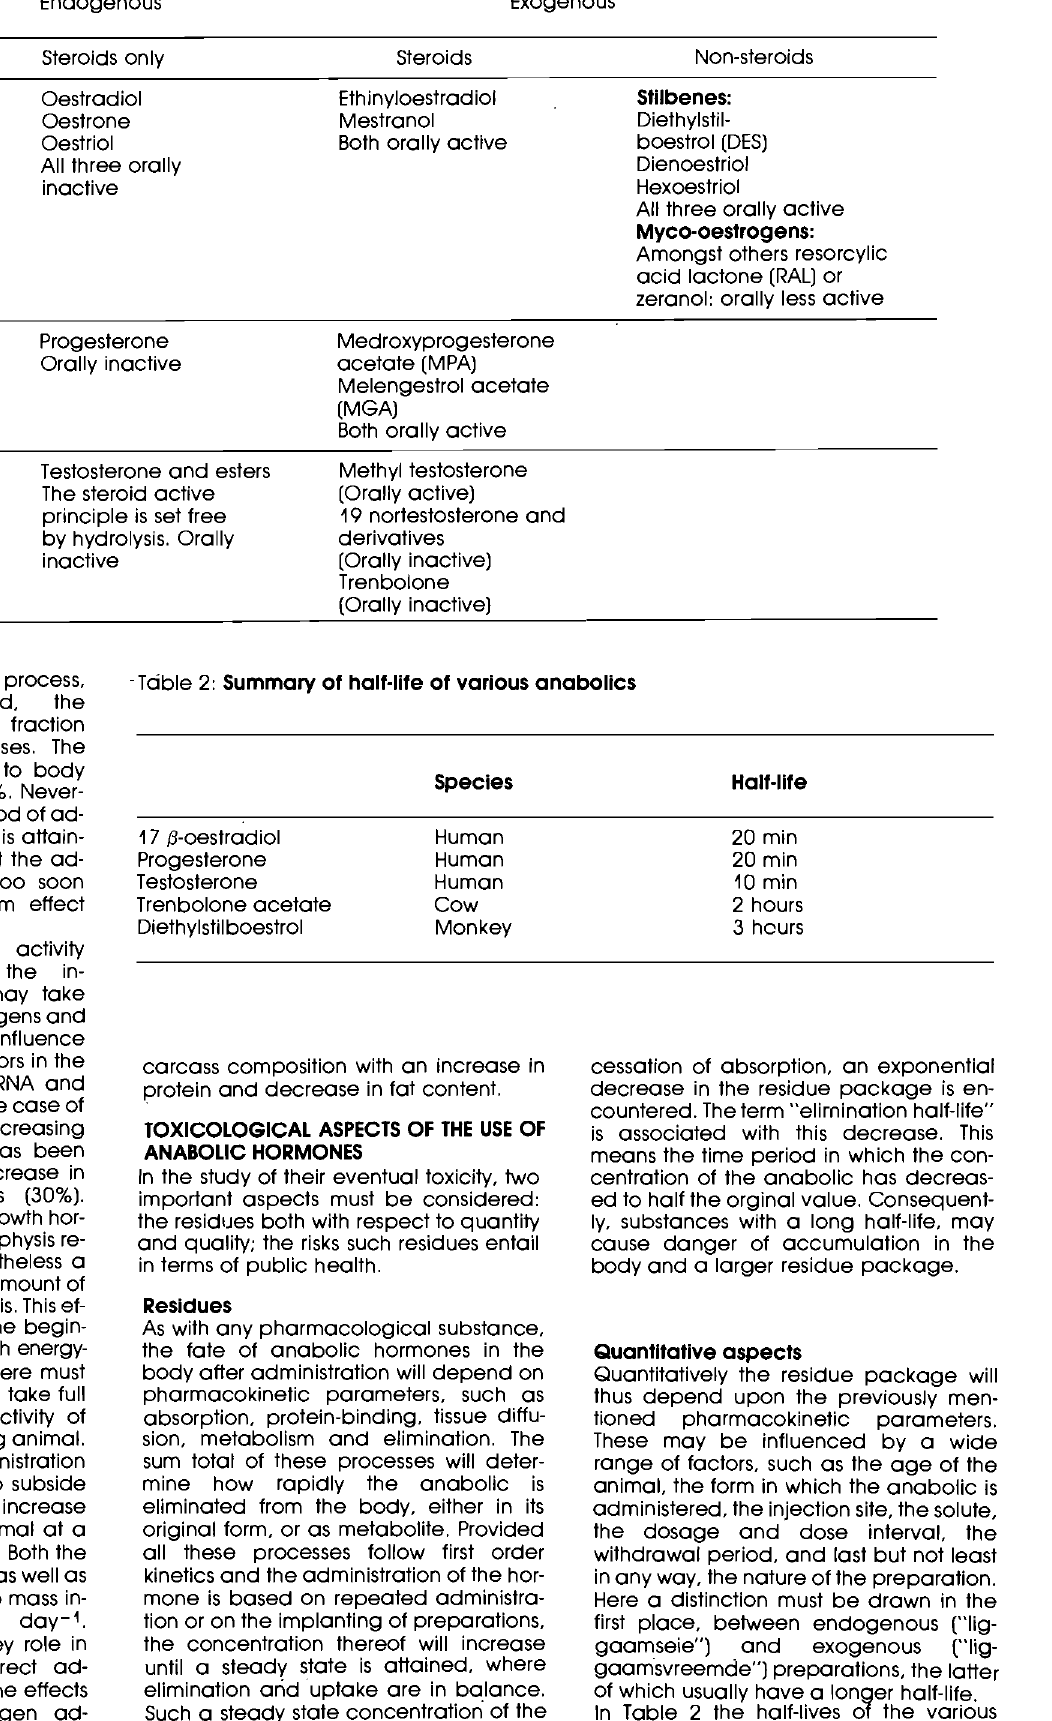
-Table 2: Summary of half-life of various